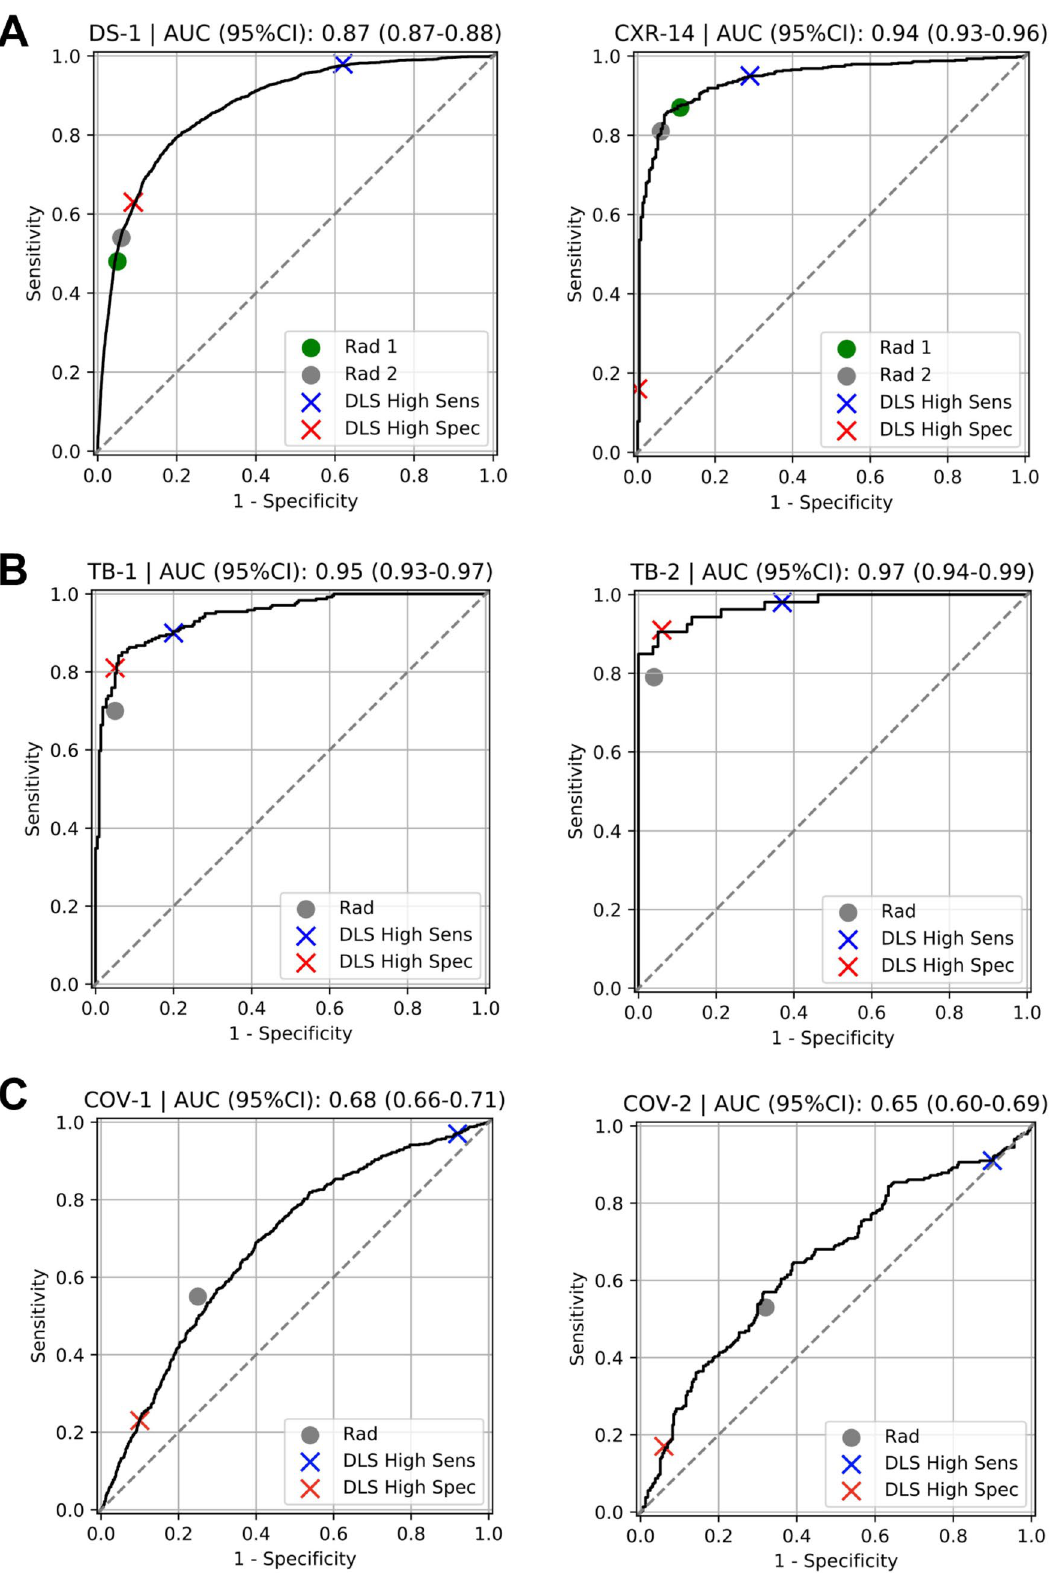
Figure 2. Receiver operating characteristic (ROC) curves for the DLS in distinguishing normal and abnormal CXRs across 6 different datasets. Positive CXRs in DS-1 and CXR-14 contain a mix of multiple labeled abnormalities (Supplementary Table 2). Positive CXRs in the two TB datasets are from patients with tuberculosis. Positive CXRs in the two COVID-19 datasets are from patients with reverse transcription polymerase chain reaction (RT-PCR)-verified COVID-19. Radiologists’ performances in distinguishing the test cases as normal or abnormal are also highlighted in the figures. DLS performance for identifying abnormalities in the TB and COVID-19 datasets (as opposed to the presence or absence of TB or COVID-19) are presented in Supplementary Fig. 6, with AUCs of 0.91-0.93 for TB and 0.86 for